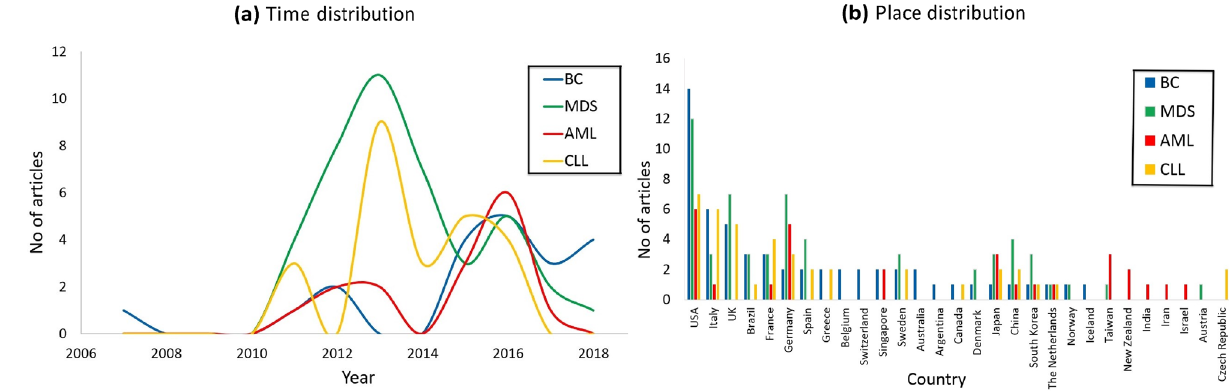
(BC), MDS, AML, and CLL are colored in blue, green, red, and orange, respectively.